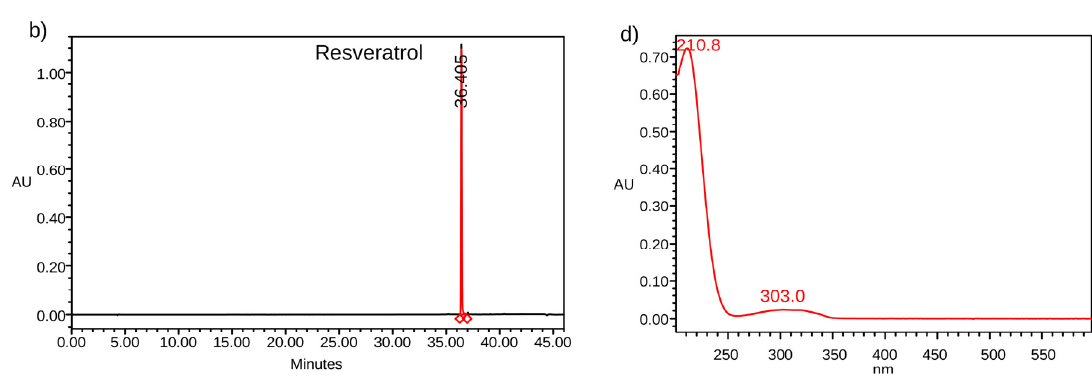
Figure 1. High-performance liquid chromatography with diode array detection (HPLC-DAD) chromatograms of the standard solutions: ( a ) piceatannol; ( b ) resveratrol. UV spectra of the standard solutions: ( c ) piceatannol; and, ( d ) resveratrol.